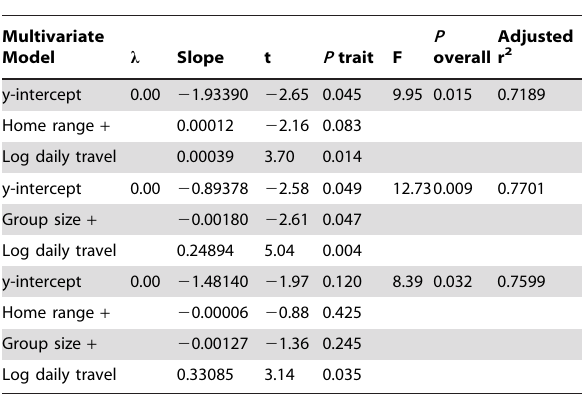
Table 3. Phylogenetic generalized least-squared multiple regression models of the relationship between Oesophagostomum prevalence and life-history variables of diurnal primates (excluding humans) within the Kibale